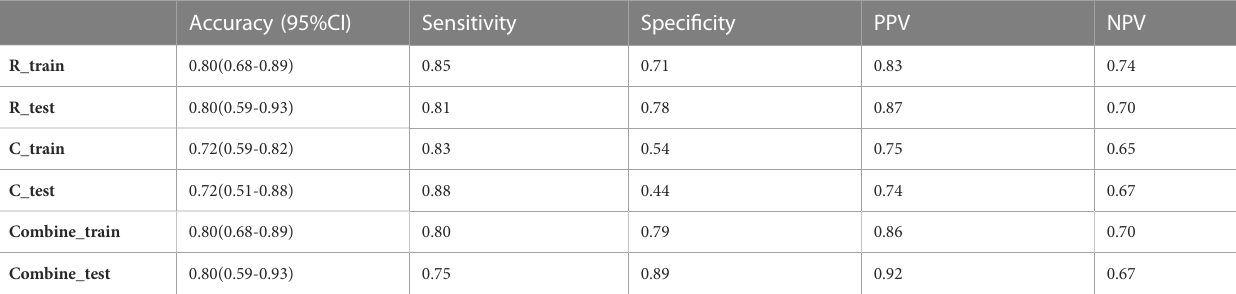
TABLE 3 Model predictive performance.